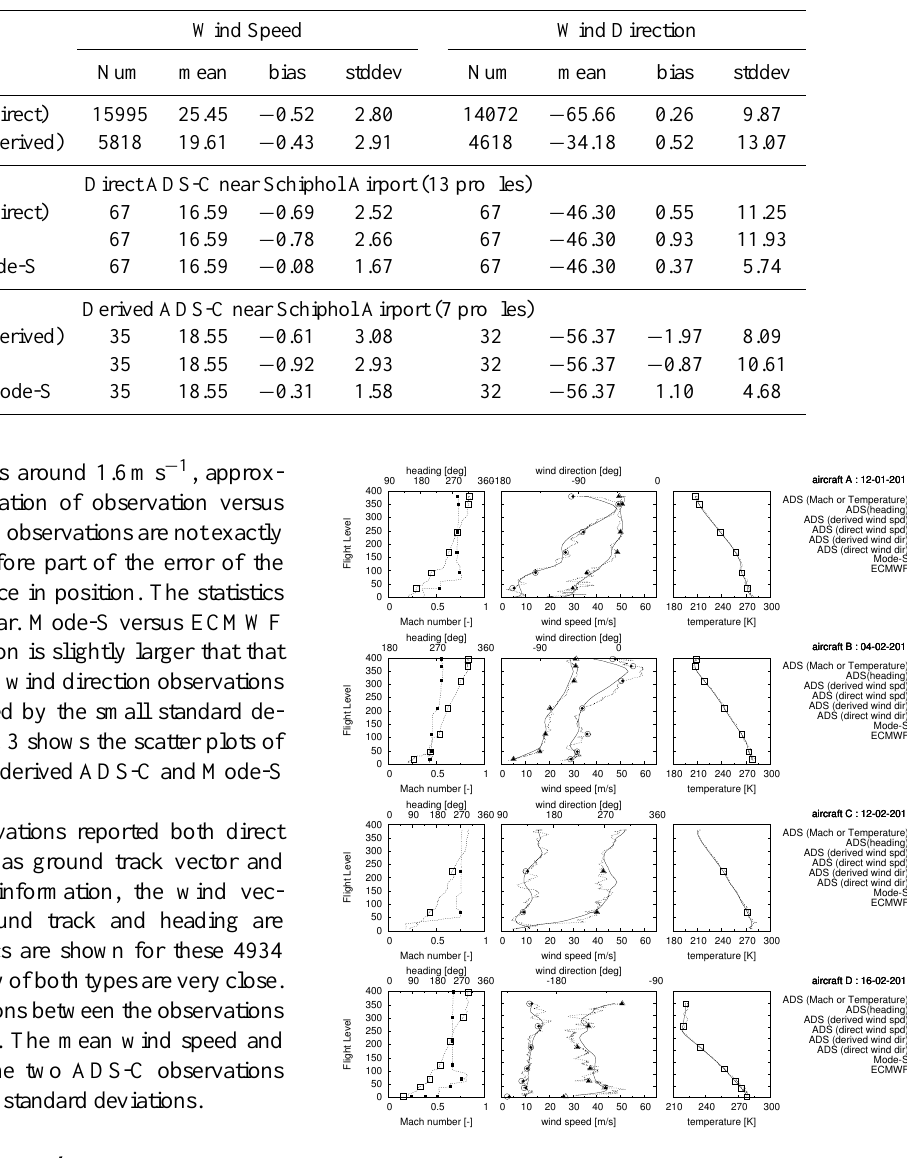
Fig. 4. Profiles of Mach number, heading, wind speed and wind direction for ADS-C reports (direct and derived) in the vicinity of Schiphol airport. Left panel of each sub graph shows the mach num- ber and heading (solid and open squares, resp.); right panel shows wind speed and direction (solid and open triangles, resp.). Also shown are Mode-S heading, Mach number and wind speed and di- rection (dashed line) and ECMWF wind speed and direction (solid